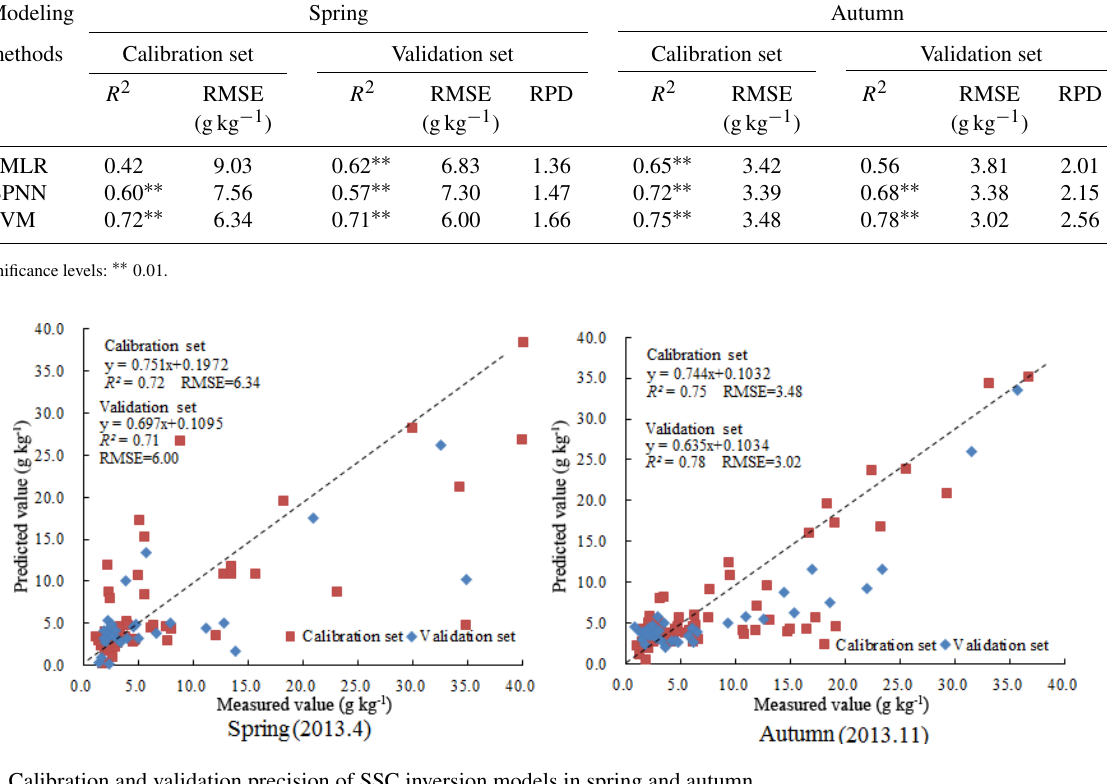
Table 2. Inversion models of SSC with IVIs from Landsat data. Modeling Spring Autumn methods Calibration set Validation set Calibration set Validation set